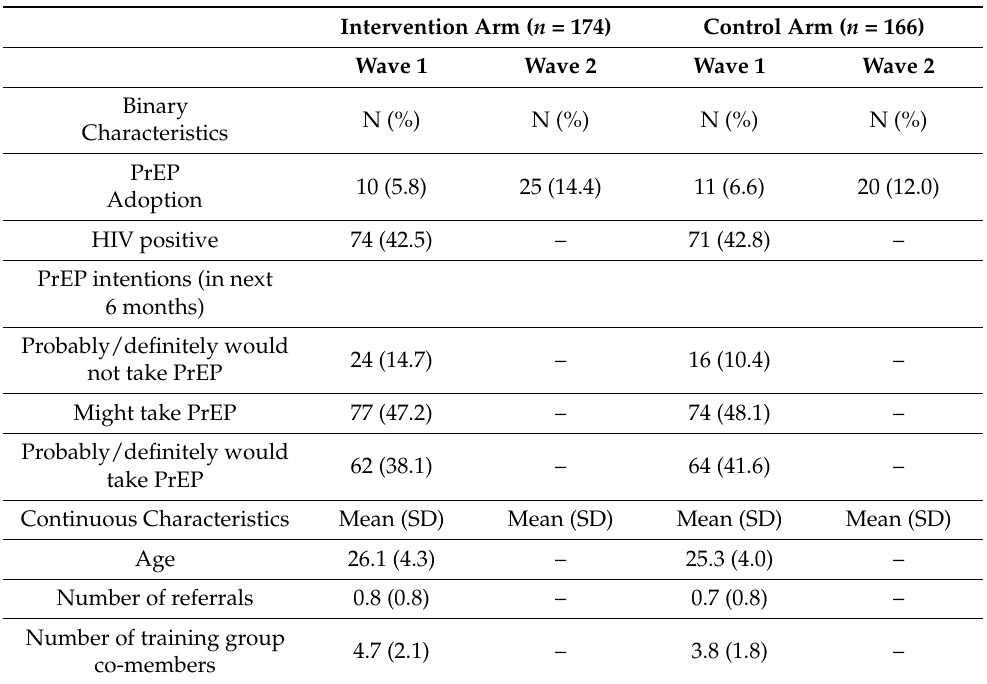
Table 2. Characteristics of YBMSM study participants, stratified by intervention and control group assignment in Year